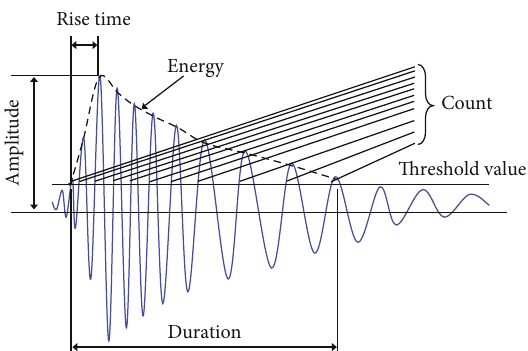
Figure 1: Parameters of AE